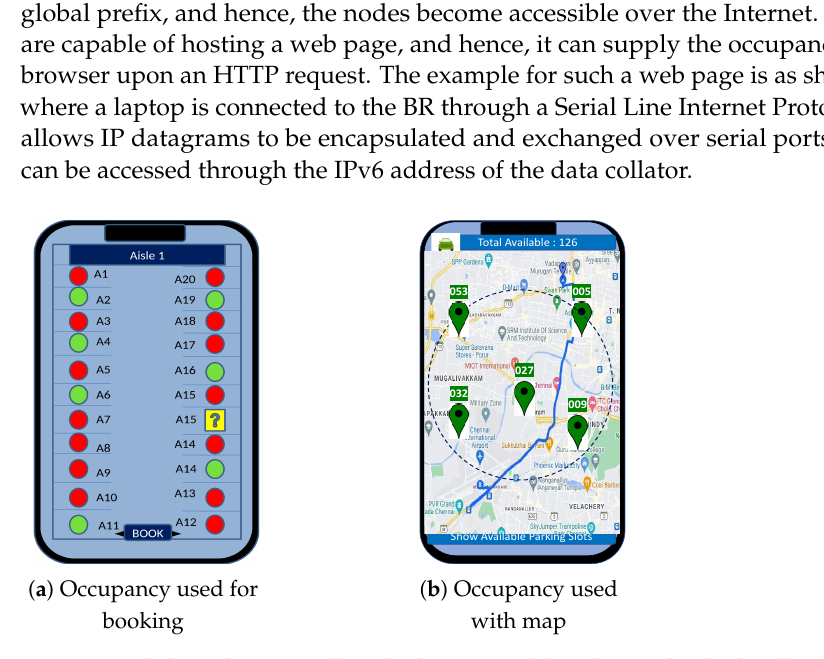
Figure 4. Mobile application with multiple services. ( a ) Booking individual parking slot. ( b ) Searching for available parking slots in a map.